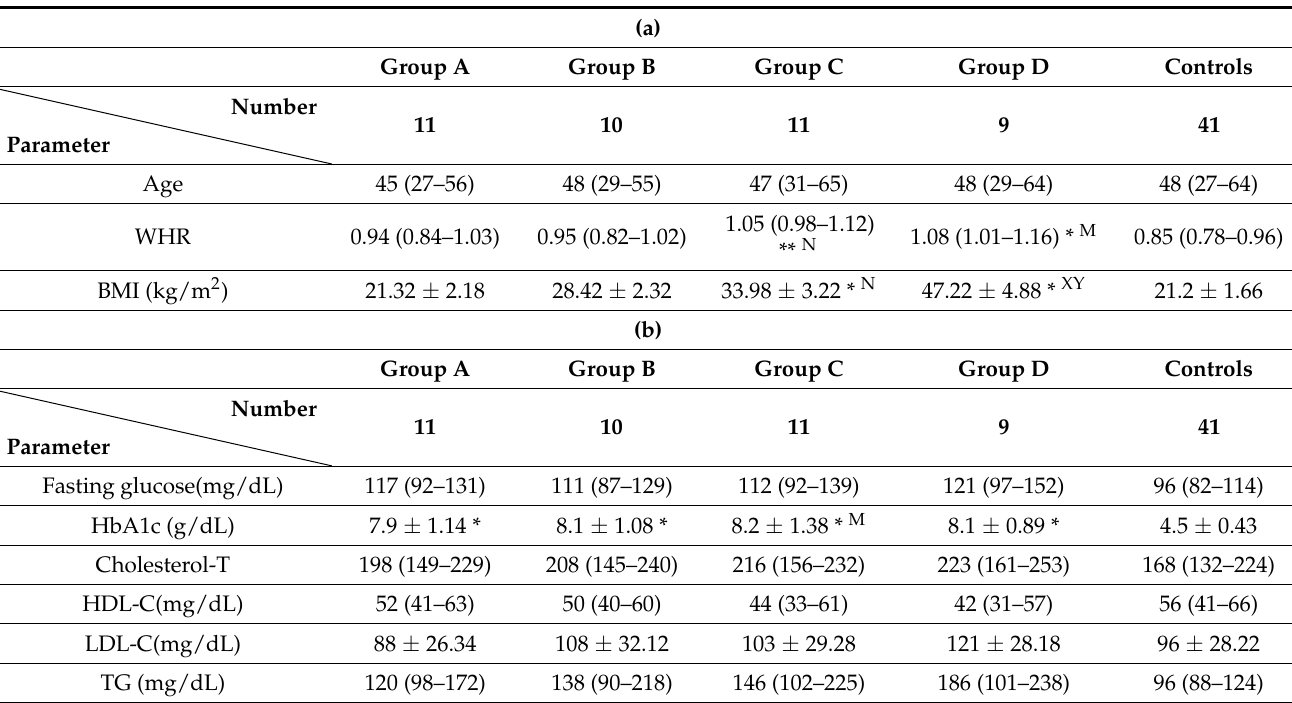
Table 2. ( a ) Anthropometric indices of female T2DM patients and controls. ( b ) Biochemical parame- ters of female T2DM patients and controls.